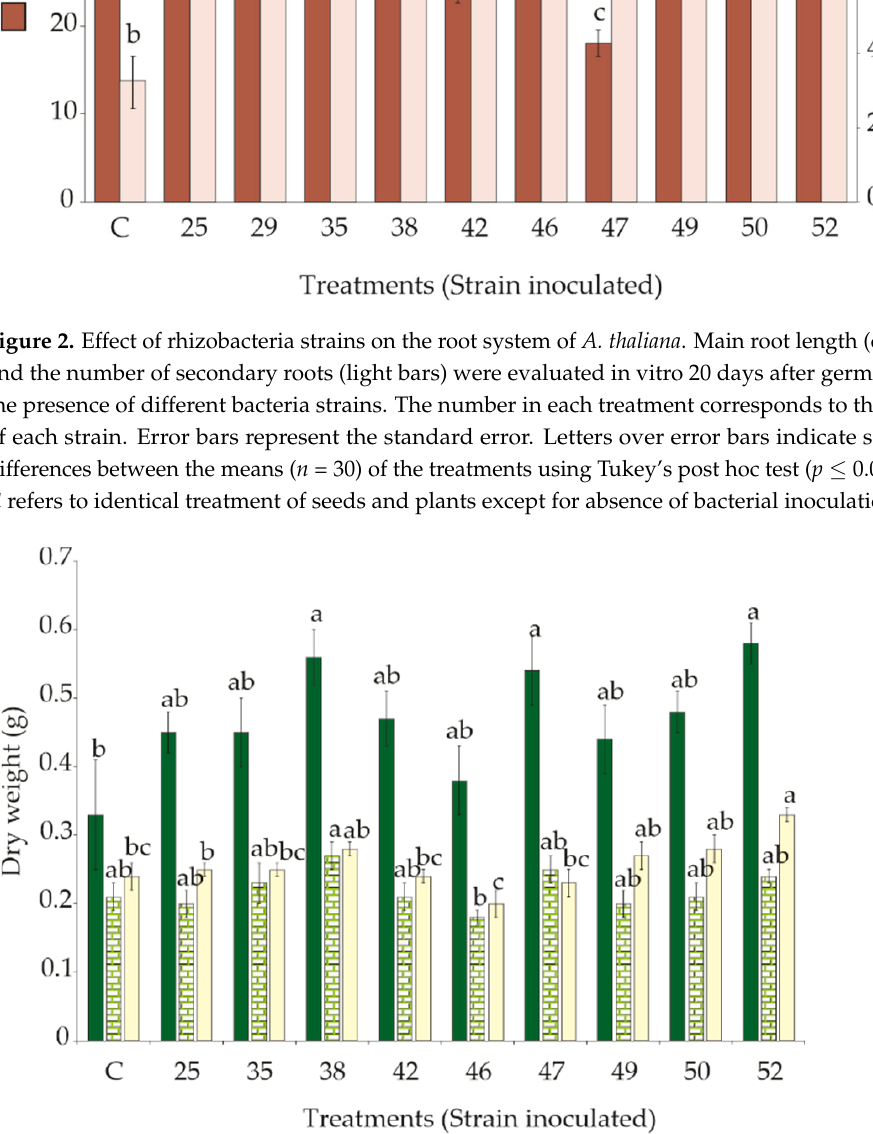
Figure 3. Effect of rhizobacteria strains on biomass and survival over nursery S. macrophylla . Total dry weight of leaves (dark bars), stems (patterned-filled bars), and roots (light bars) was determined three months after germination and inoculation with different rhizobacteria strains. C letter refers to control treatment (non-inoculated). Letters over error bars indicate significant differences between the means ( n = 30) of the treatments using Tukey’s post hoc test ( p ≤ 0.05).